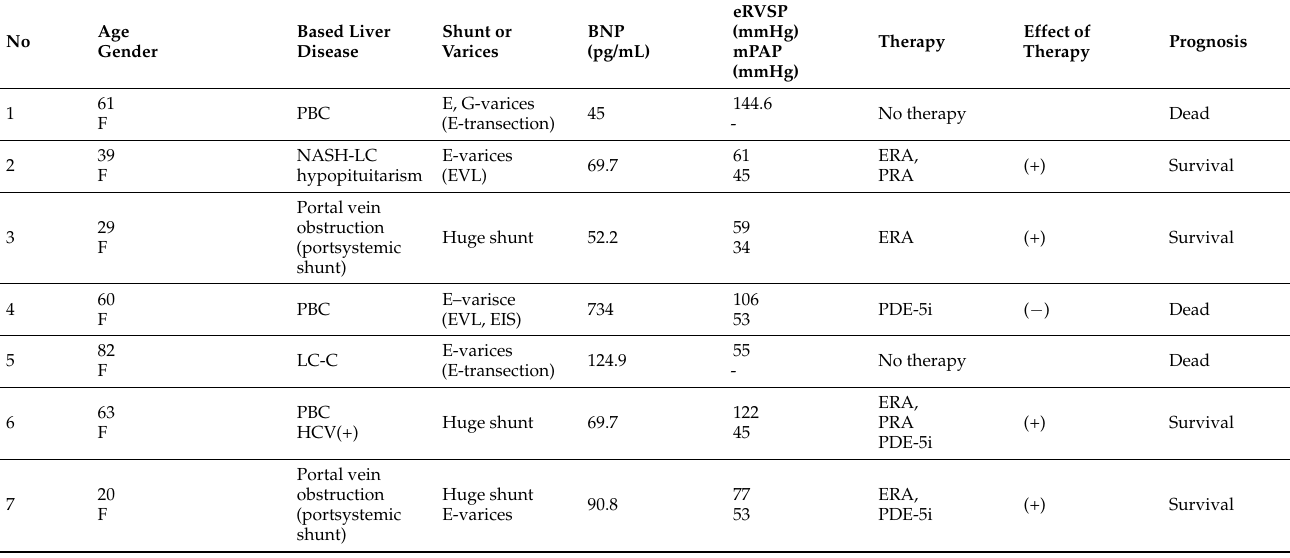
Table 1. Cases with portopulmonary